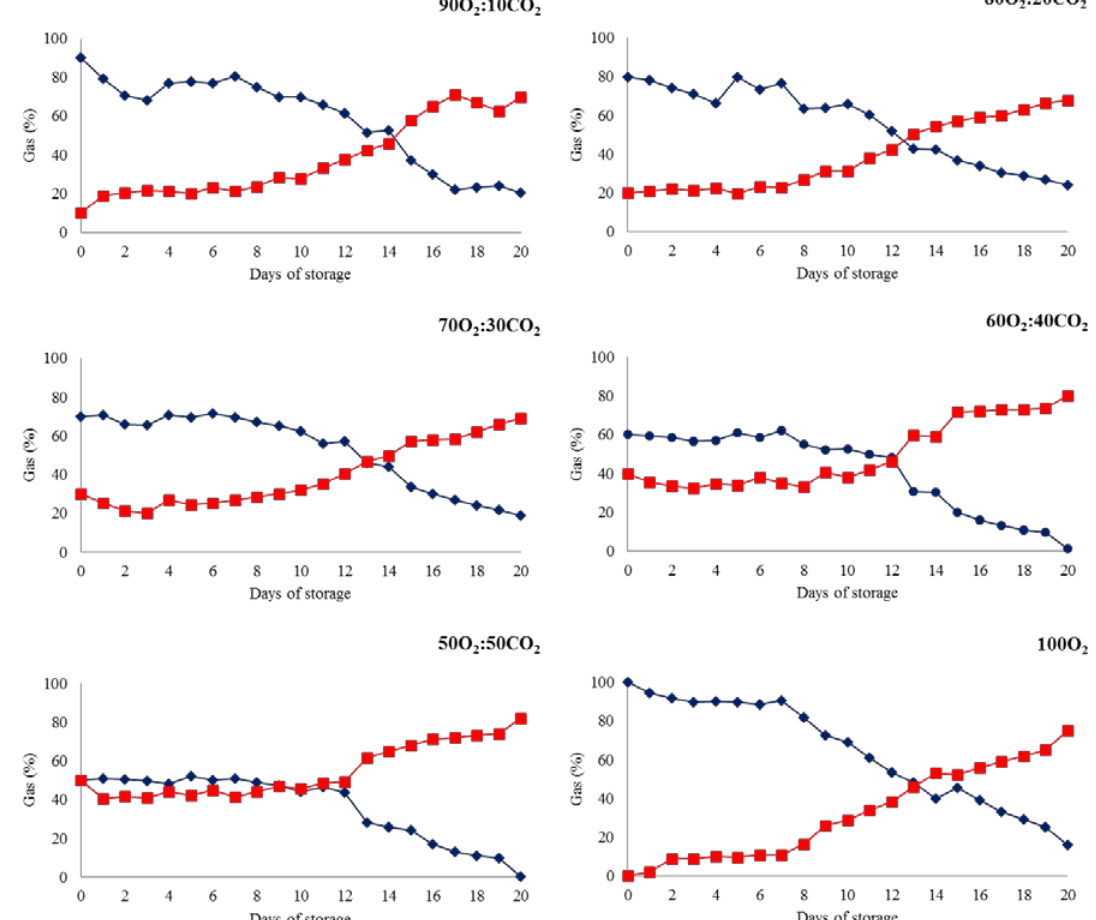
Figure 1. Effect of storage time on the headspace O 2 (blue color) and CO 2 levels (red color) of ground beef treated with different packaging systems stored at 2 °C for 20 days. 90O 2 :10CO 2 , 80O 2 :20CO 2 , 70O 2 :30CO 2 , 60O 2 :40CO 2 , 50O 2 :50CO 2 , and 100O 2 (modified atmosphere packaging with 90%:10%, 80%:20%, 70%:30%, 60%:40%, 50%:50%, and 100%:0% oxygen and dioxide carbon ratios, respectively).